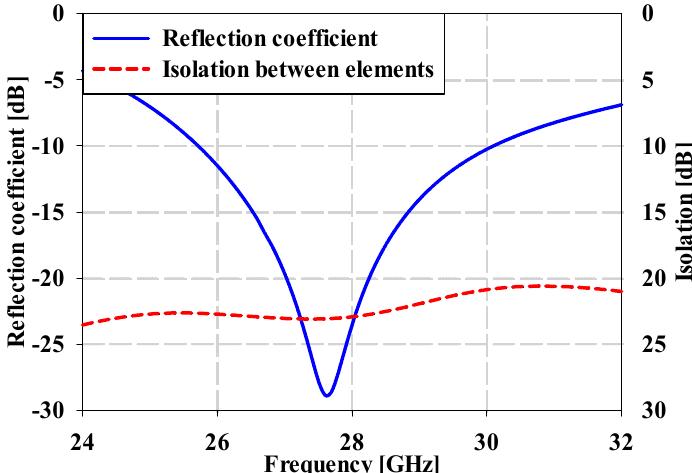
Figure 9. Reflection coefficient of the proposed antenna and isolation between the elements.